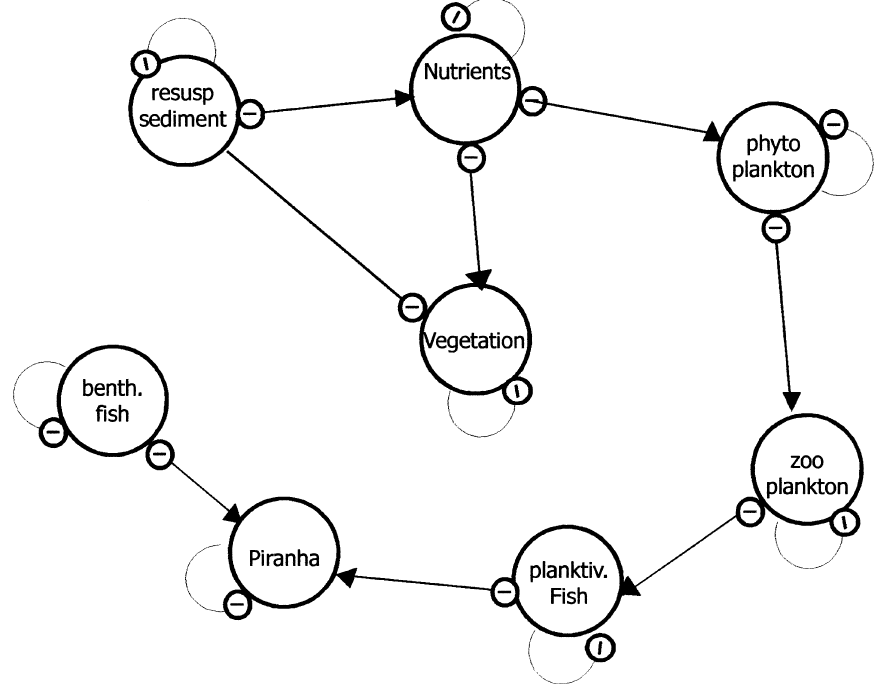
Fig. 3. Alternative model using the same biotic and abiotic variables as utilised in Fig. 2. These variables are: nutrients, aquatic macro- phytes (rooted emergent and submersed aquatic vegetation), phytoplankton, resuspension of lagoon sediment, zooplankton, small planktivorous fish, piranha and benthivorous